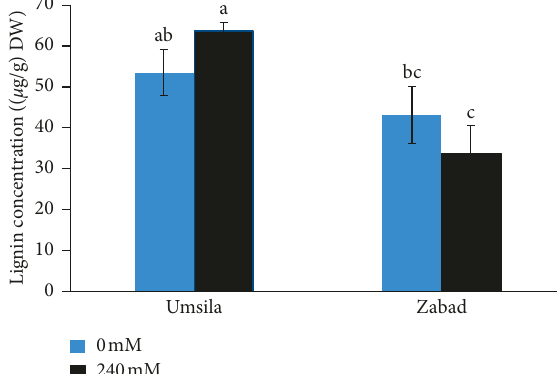
Figure 9: Effect of salinity on the lignin concentration in root tissues of date palm seedlings when grown under control and salinity conditions. Bars represent mean ± SE ( n � 3). Bars with the same letter are not significant at p ≤ 0 .